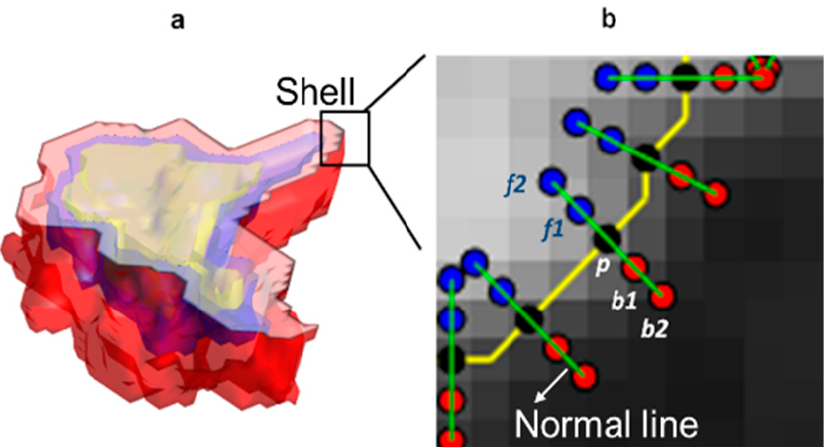
Figure 3. A pictorial representation of the NIS feature extraction. ( a ) A nodule is partitioned into three nested shells (denoted by yellow, purple and pink colors). The annular shells are computed by applying binary dilation and erosion on the nodules volume. ( b ) 2D representation of the outer shell’s border pixels (black dots) and their corresponding normal lines (green lines) including inner ( f i , blue dots) and outer ( b i , red dots) pixels over the normal line. The yellow line denotes the boundary of the shell.